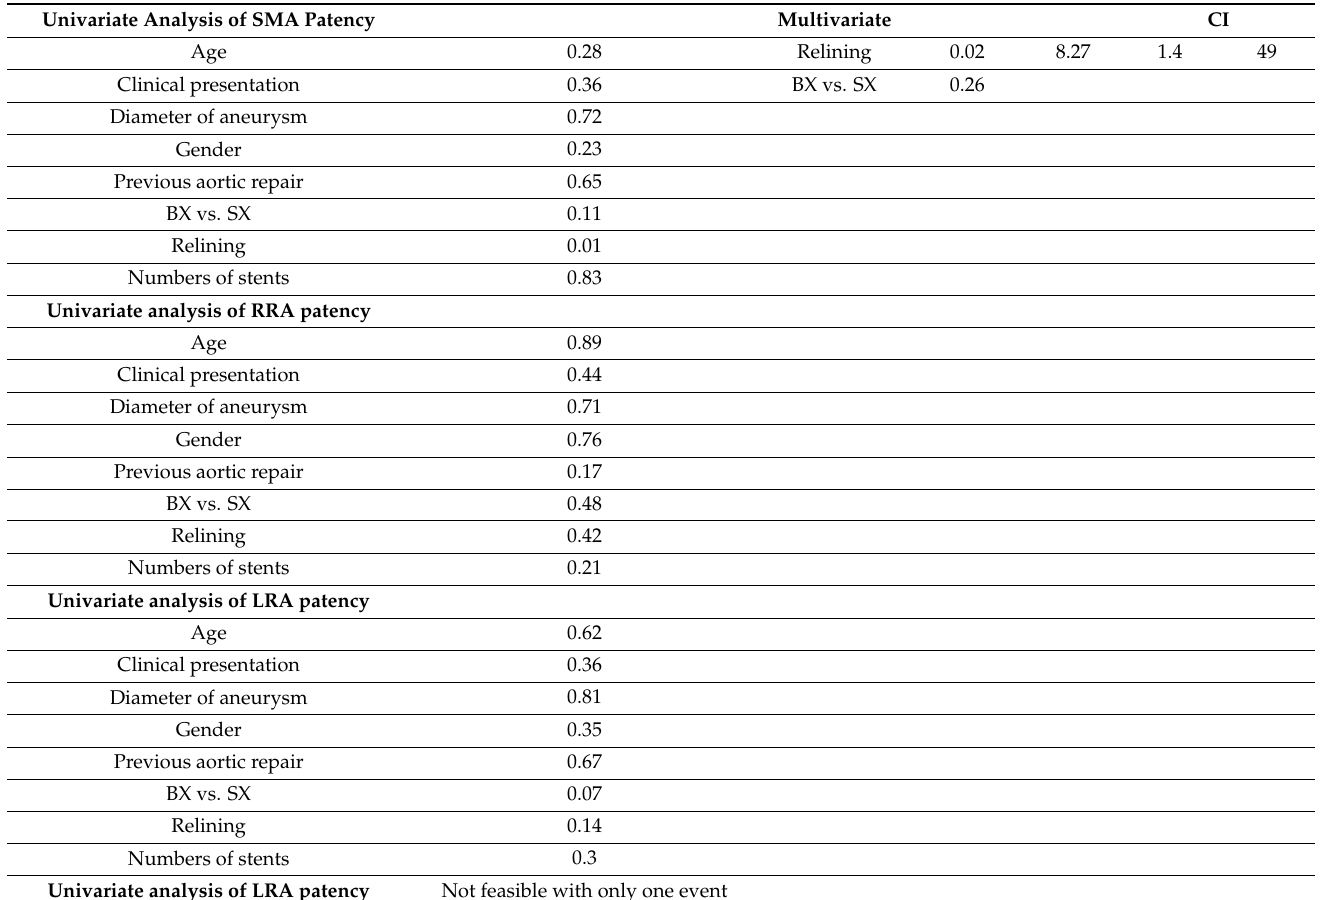
Table 5. Univariate and multivariate analysis of factors associated with target vessel patency. SMA: superior mesenteric artery; RRA: right renal artery; LRA: left renal artery; CT: coeliac trunk; BX: balloon expandable; SX: